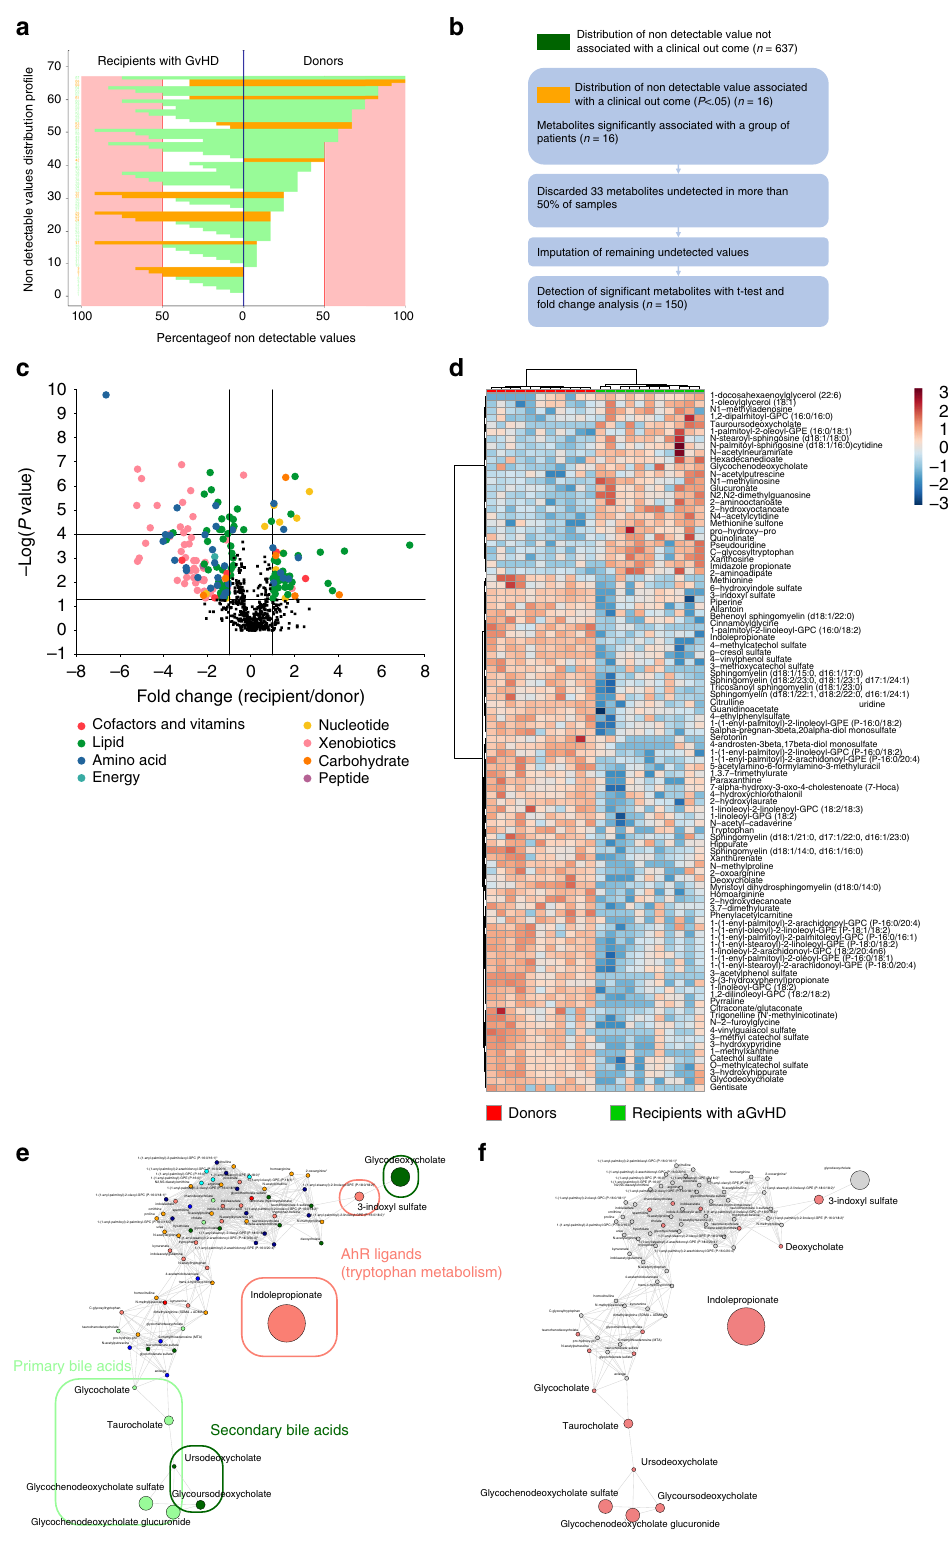
metabolized BA 51 . Bile acids effects on immune response and